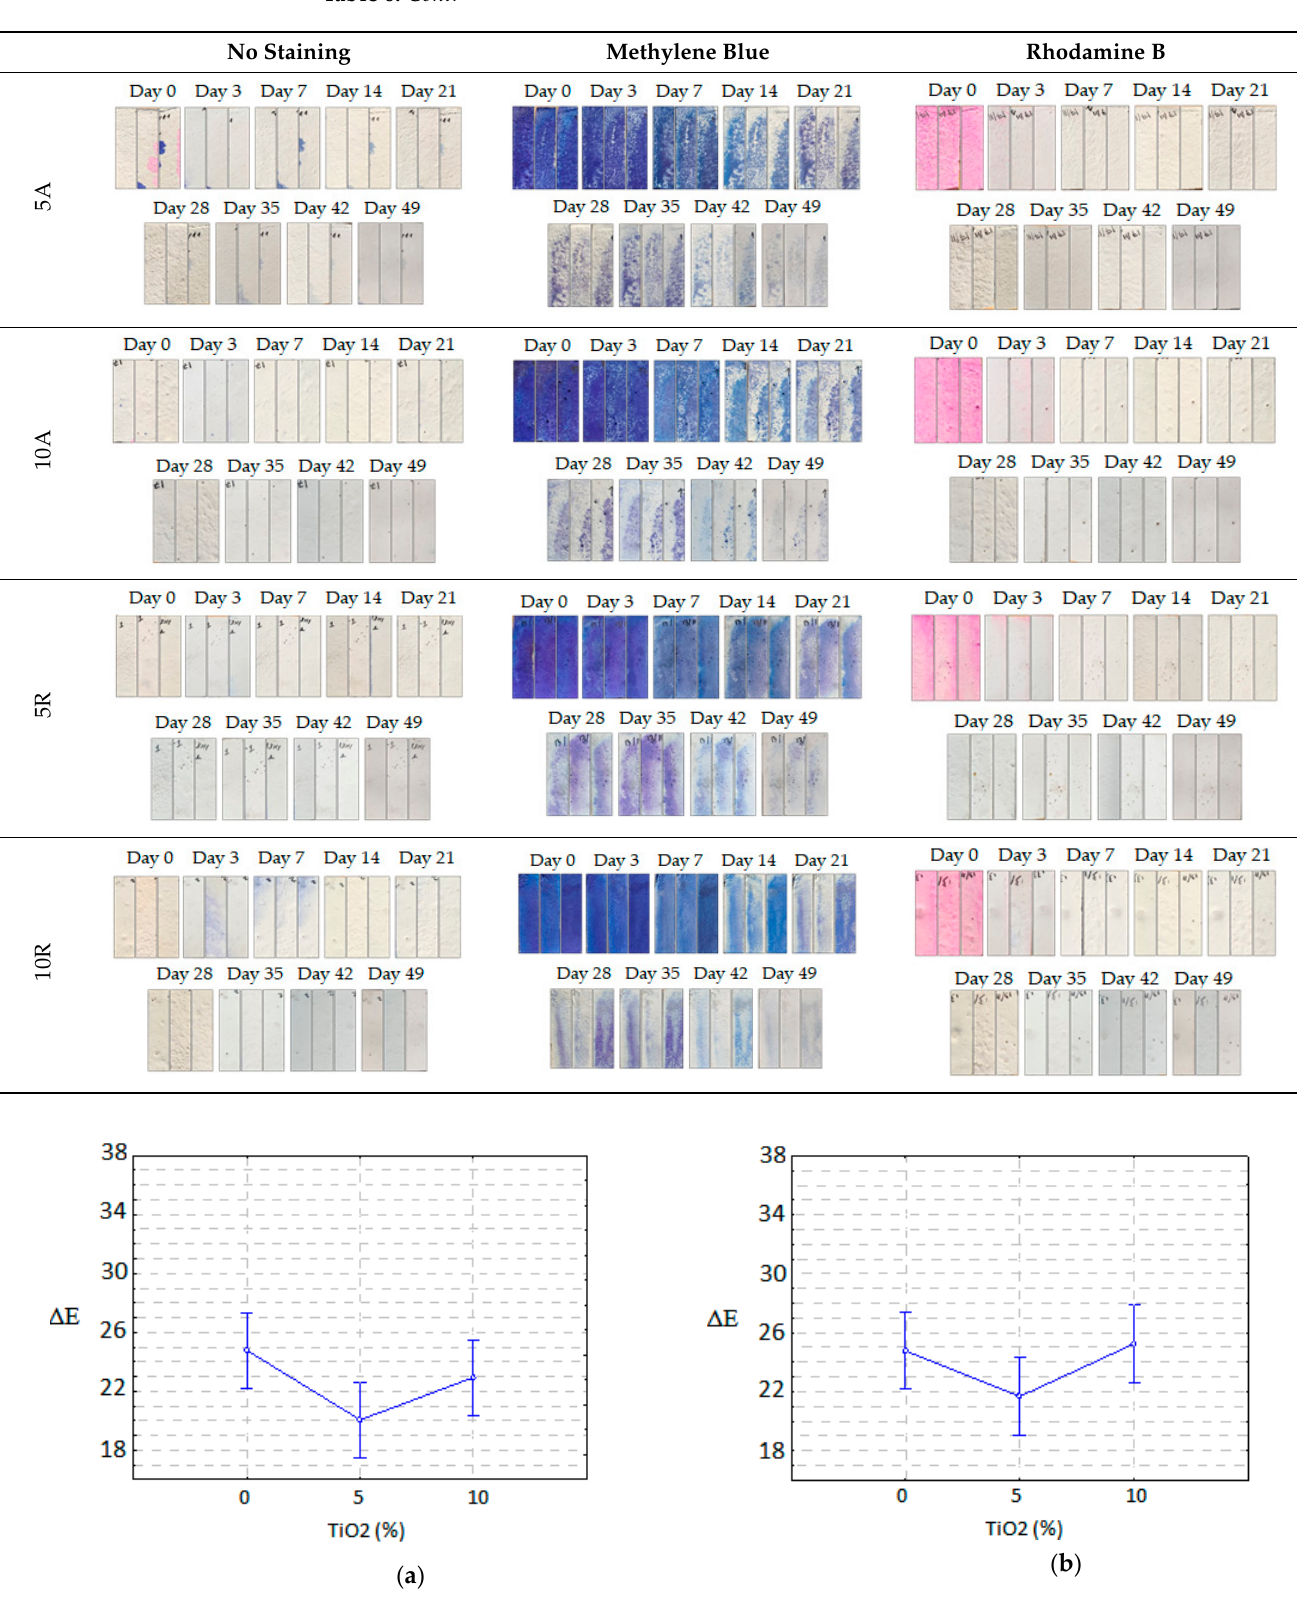
Table 7. Main effects analysis of variance on tiles produced with TiO 2 rutile and anatase, with and without staining by methylene blue, subjected to UVA radiation.